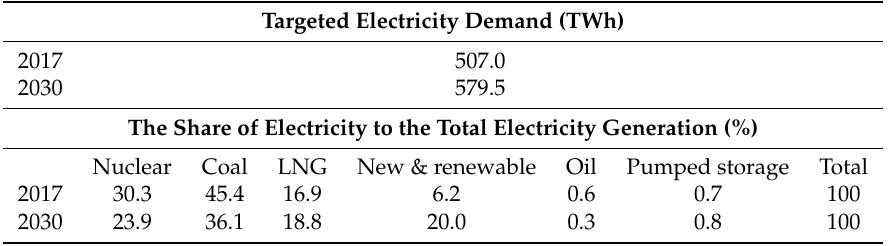
Table 3. Summary of electricity demand and energy